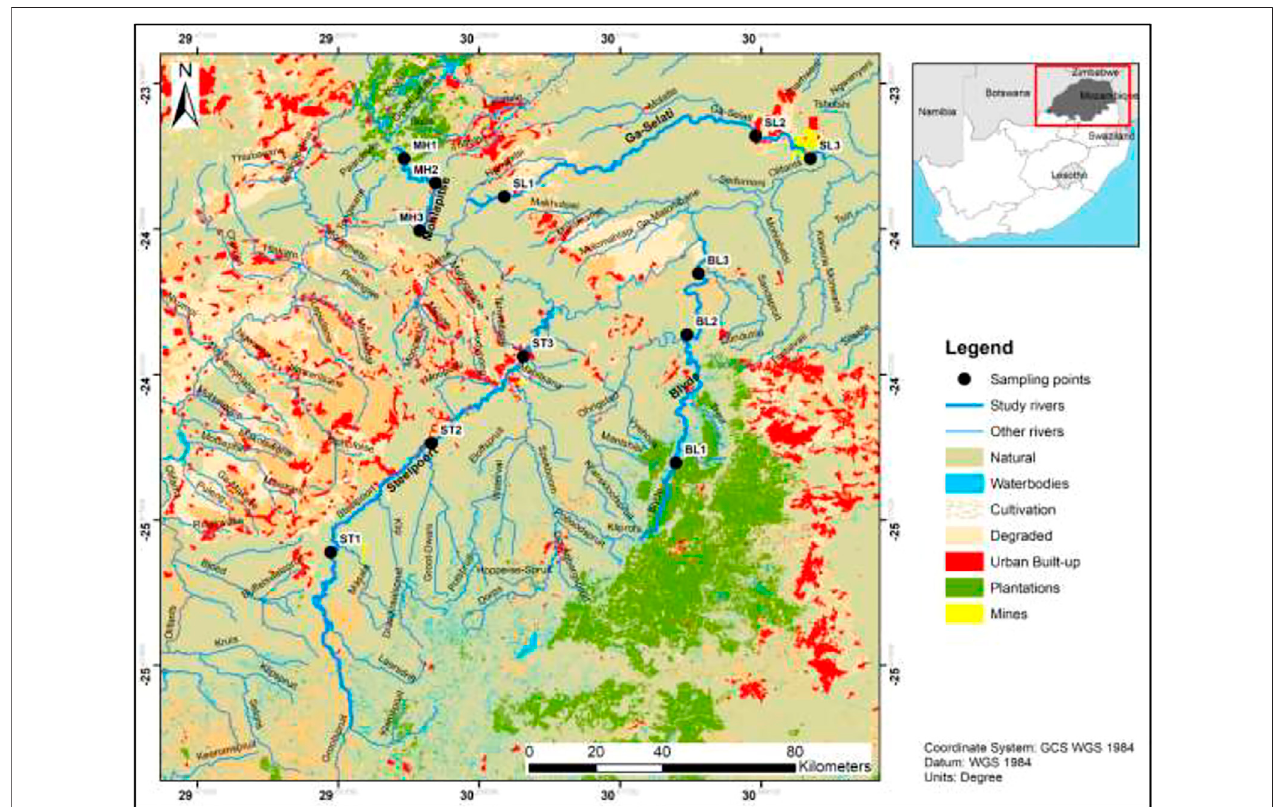
FIGURE 1 | Map showing the locations of the sampling sites of the four rivers in the Lower Olifants River.